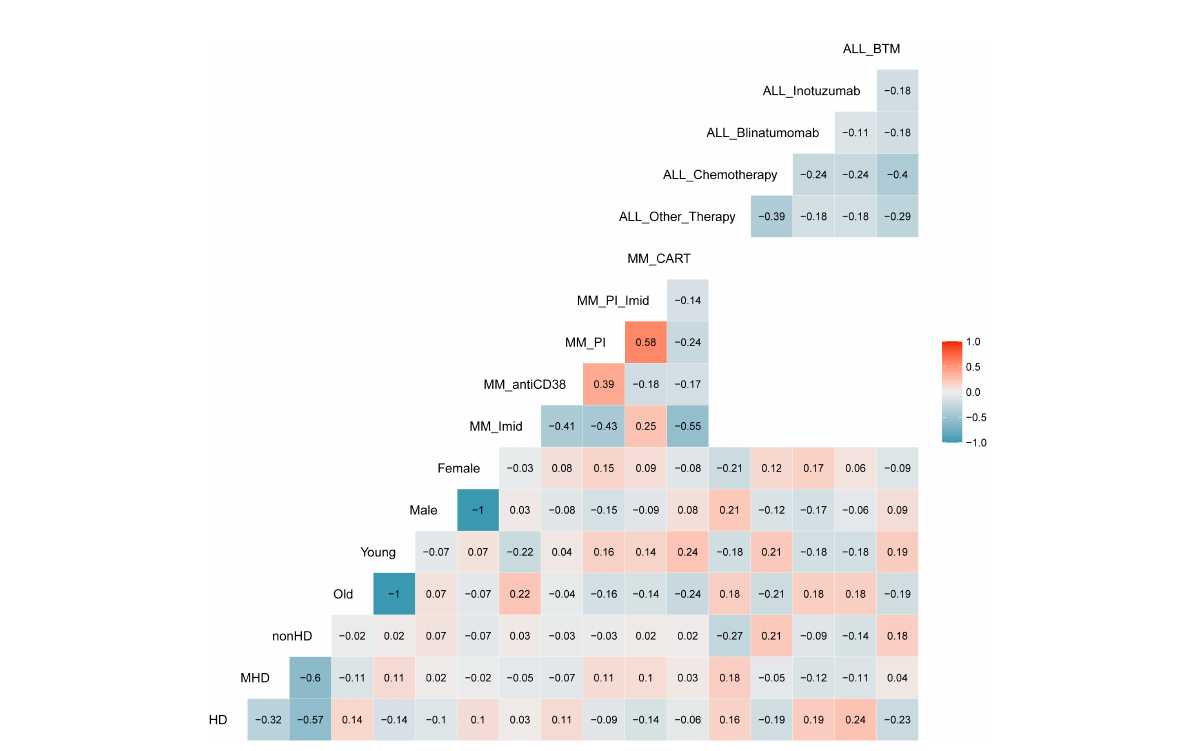
FIGURE 6 Correlation matrix between ALLgorithMM -de fi ned BM hemodiluted (HD), mildlyHD (mHD) and non-hemodiluted (nonHD) vs. age (old or young), gender (female or male) and therapy used at the time of the sampling. Blue and red stand for negative or positive correlations, respectively. Color intensity is proportional to the correlation coef fi cients. The fi gure shows an absence of correlation between the 3 HD groups and others variables, con fi rming the robustness of the ALLgorithMM .